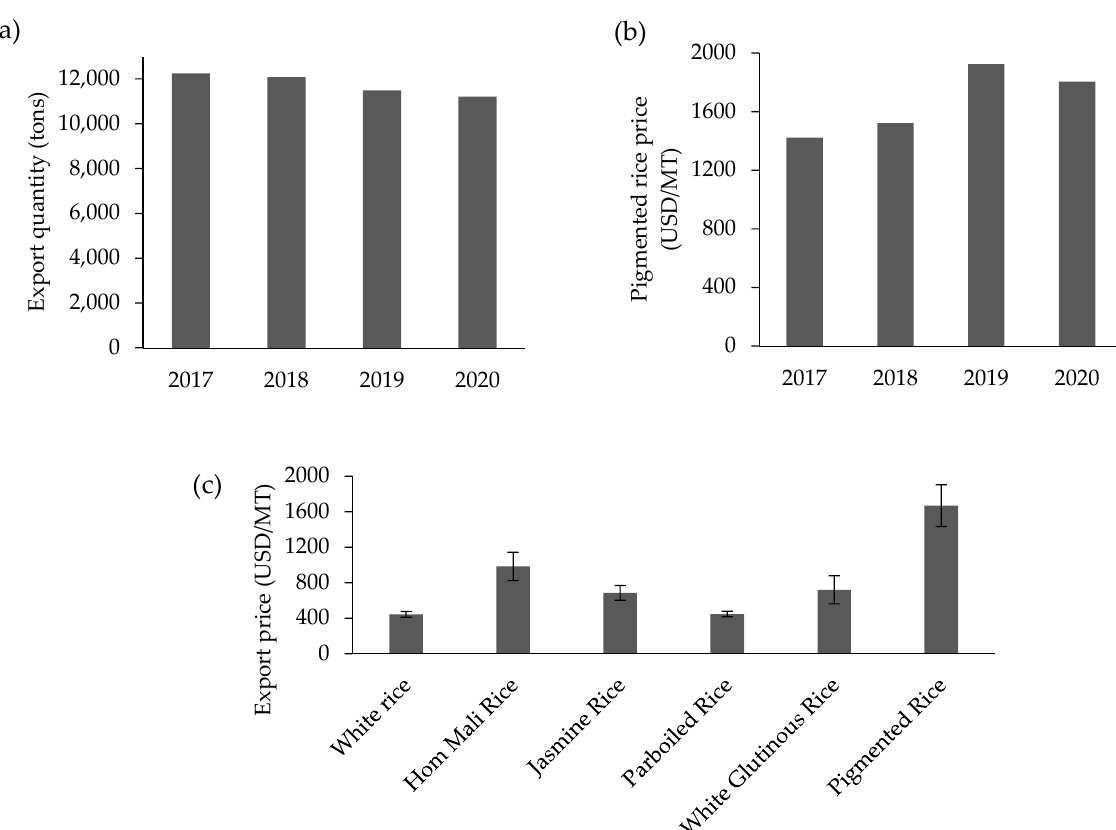
Figure 2. Thailand’s export quantity ( a ) and price ( b ) of pigmented rice and the average price of selected rice types ( c ) during 2017 to 2020. Source: drawn using data from OAE 2021.